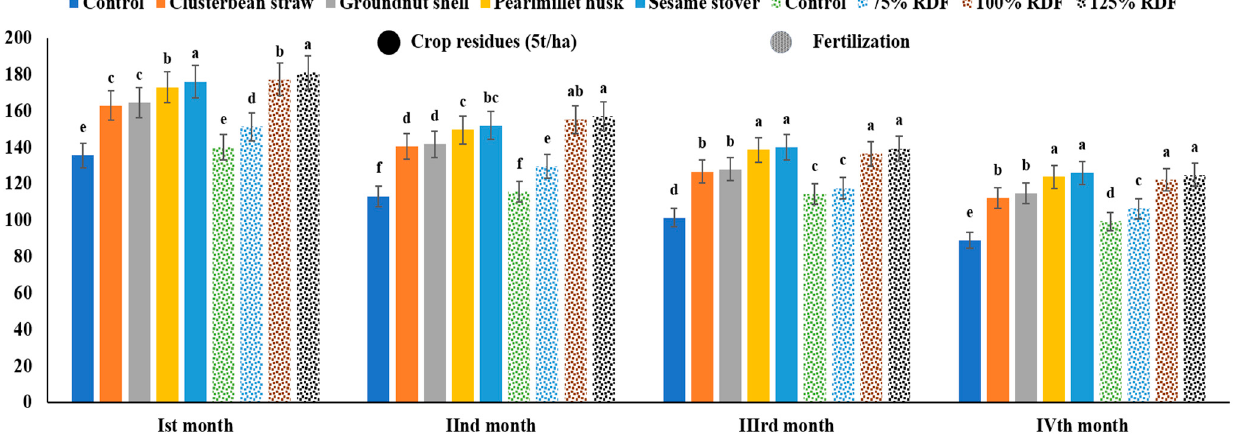
Figure 3. Effect of crop residues and fertilization on microbial biomass phosphorus (µg g − 1 ) at first, second, third, and fourth month after sowing. In this figure, the values followed by different lower- case letters indicate no significant difference ( p > 0.05) by Duncan’s multiple range test (DMRT) 3.2. Soil Enzymes Different crop residues and fertilization treatments had considerable effects on the dehydrogenase activity accessed in soil (Table 2). The interactive effect of crop residues and fertilization on dehydrogenase activity was found to be non-significant. At the first to fourth months after sowing, the dehydrogenase activity varied from 14.26 to 19.17 g TPF kg − 1 24 h − 1 in the sesame stover and in the control treatment, respectively. The sesame stover treatments showed maximum dehydrogenase activity. In the fertilization treat- ments, dehydrogenase activity varied between 14.12 and 19.68 µg g − 1 soil 24 h − 1 in the 125% RDF and control treatments, respectively, during the first to fourth months after sowing. The application of 125% RDF and 100% RDF were found to be at par with each other.